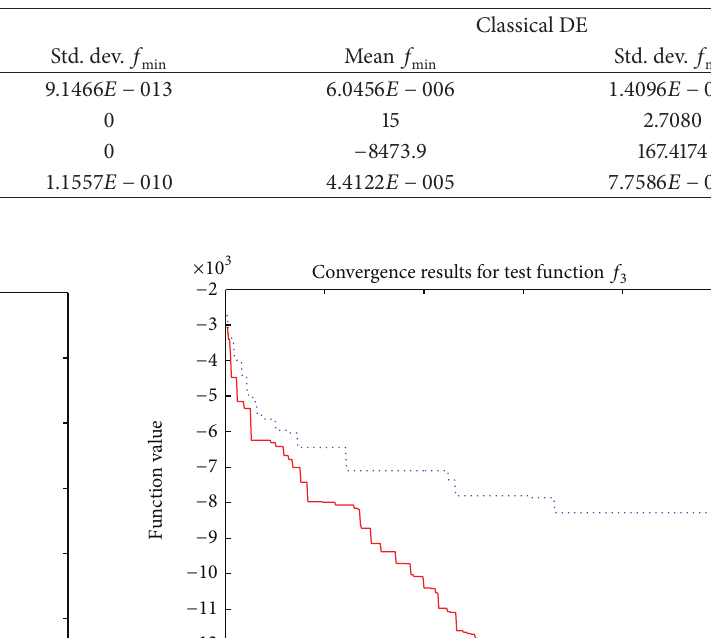
Table 2: Results of two different algorithms under four test functions.